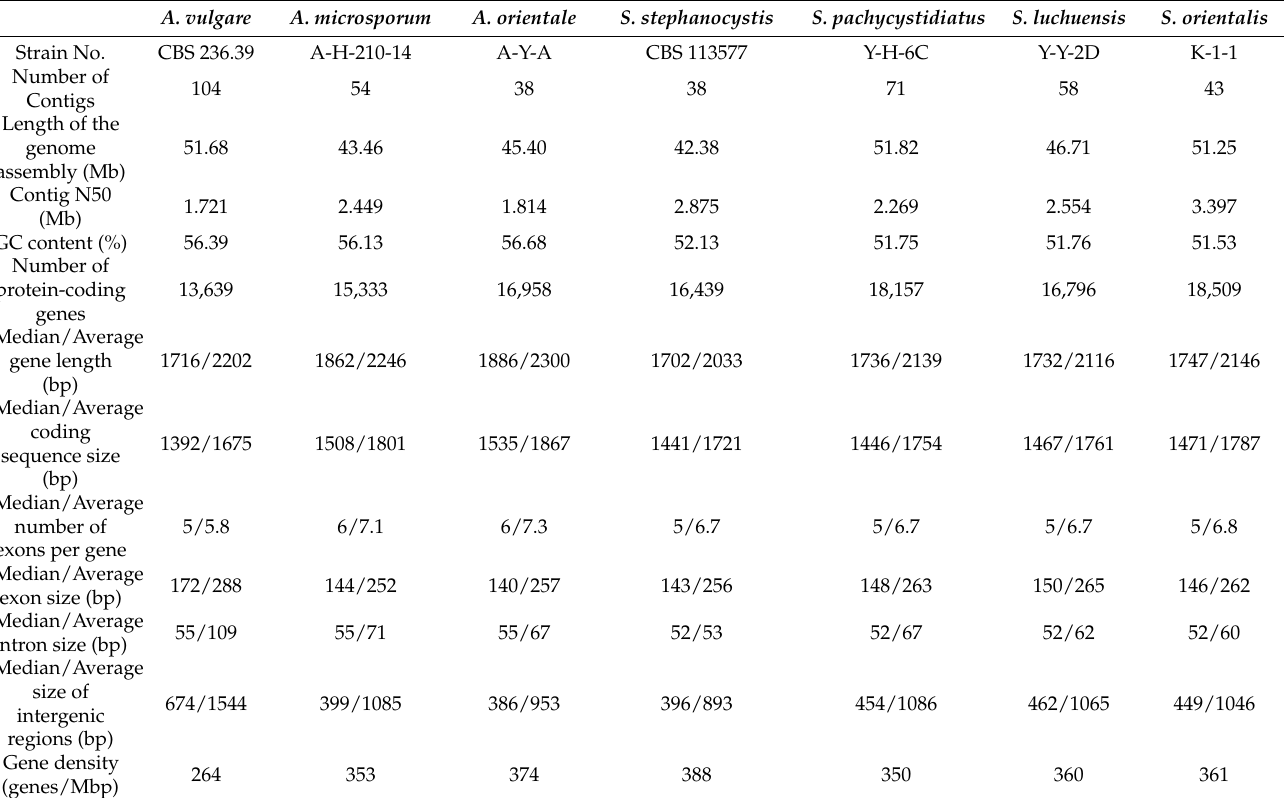
Table 1. The characteristics of the assembly scaffold and genomes of three Auriscalpium species and four Strobilurus